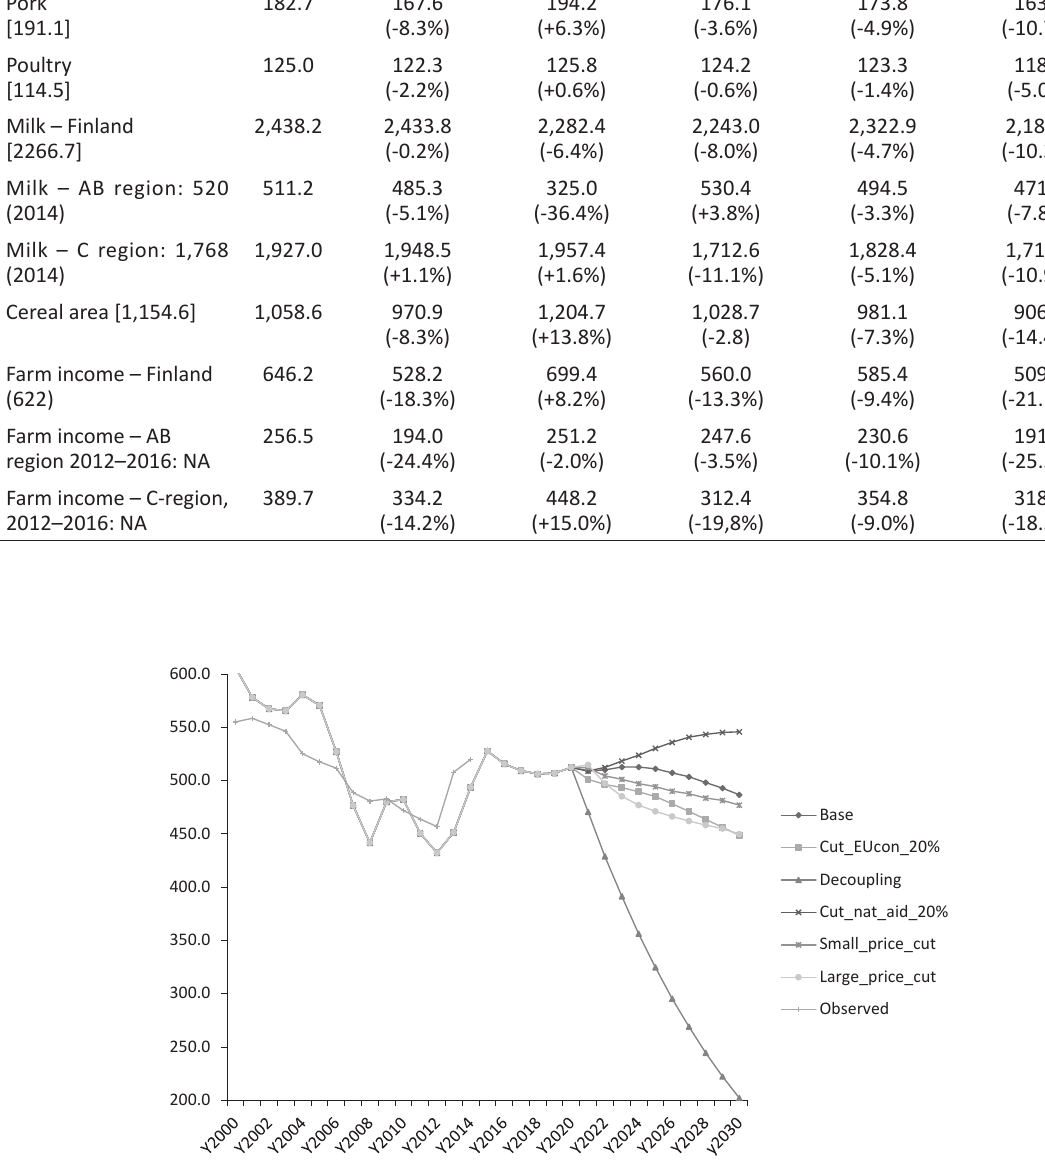
Fig. 4. Simulated milk production (million litres) 2000–2029 in different scenarios vs observed milk production 2000–2016 in the AB support region (southern Finland)